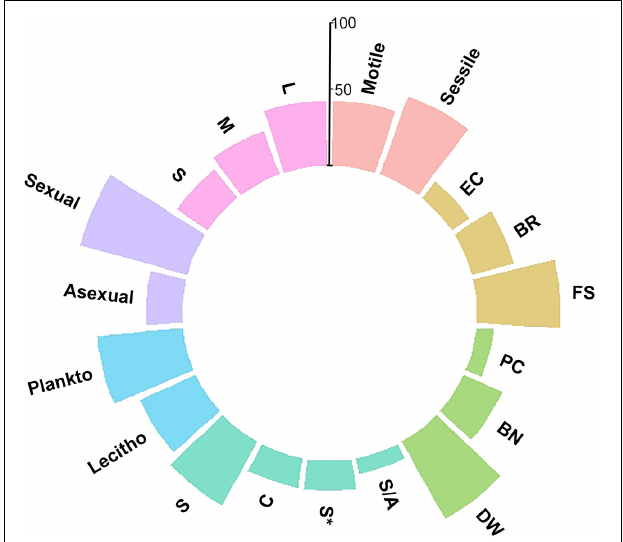
FIGURE 3 | Percentage of the species characterized by functional traits taken into account in the description of the ram assemblage structure. Colors are used to distinguish among functional traits, following the classification in Table 1 . Pink: Adult motility; Orange: Development strategy (BR = brooding; FS = free spawning; EC = egg capsules/masses); Green: Engineering (PC = primary constructors; BN = binders; DW = dwellers); Cyan: Modularity (S = solitary; S* = solitary/few individuals; S/A = solitary/aggregation; C = colonial); Blue: Larval type (Plankto = planktotrophic larvae; Lecitho = lecitotrophic larvae); Purple: Reproduction mode; Light purple: Size (S = small; M = medium; L = large).